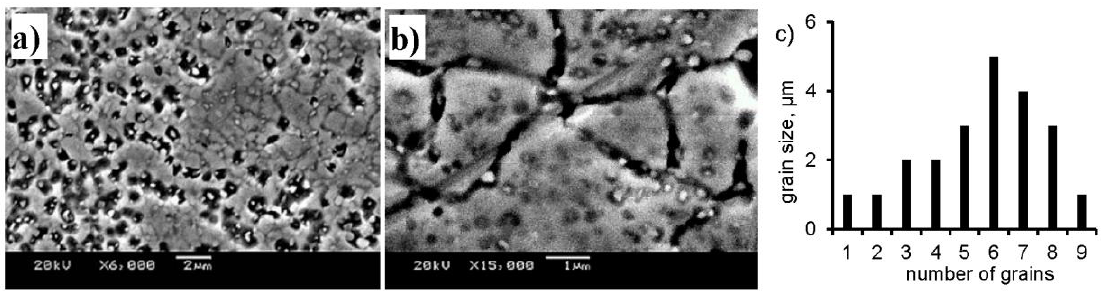
Figure 3. Scanning electron microscopy of the Co-Ni-Nb alloy structure after annealing at 773 K (1 h) + 90% rolling at room temperature and the annealing at 1153 K (25 min) (picture ( a ) with 6000 magnification and picture ( b ) with 15,000 magnification) and grain size histogram ( c ) obtained by the intercept method.